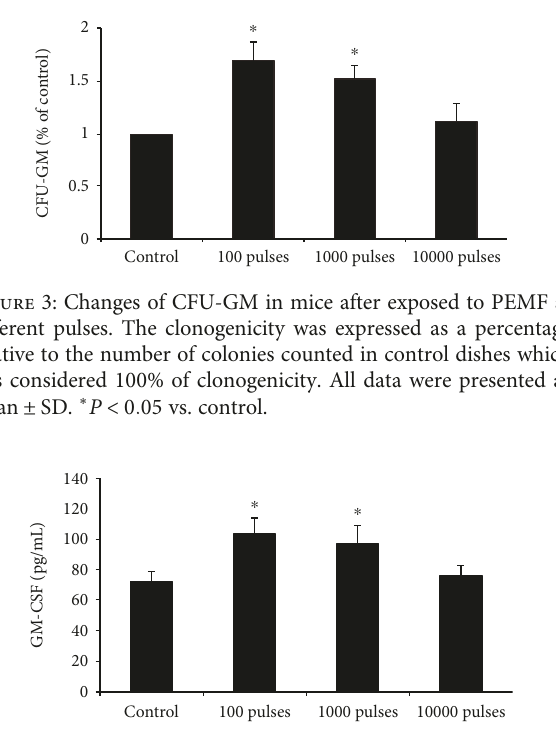
Figure 4: Changes of GM-CSF level in mouse serum after exposed to PEMF at di ff erent pulses. Blood samples were collected and the level of GM-CSF was assessed using the standard ELISA method. All data were presented as mean ± SD . ∗ P < 0 05 vs.